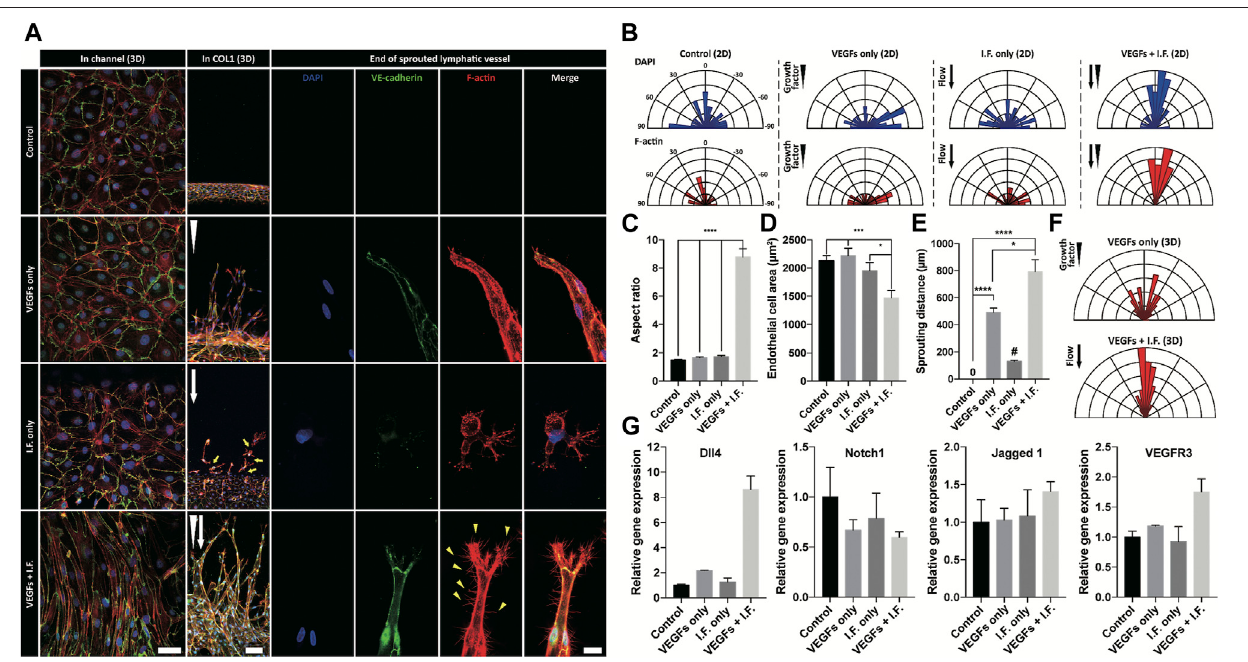
FIGURE 3 | Morphological analysis of lymphatic endothelial cells and sprouted lymphatic vessel under growth factor and interstitial fl ow stimulation. (A) Immuno fl uorescent images of lymphatic endothelial cells in a cell-cultured channel ( fi rst column) , a sprouted lymphatic vessel in COL1 (middle column) , and end of sprouted lymphatic vessel (third column) . White arrowhead and arrow indicate growth factor gradient and interstitial fl ow direction, respectively. Scale bars are 50 μ m ( fi rst column) , 100 μ m (second column) , and 20 μ m (third column). (B) Polar distribution of lymphatic endothelial cell ’ s orientation in the cell-cultured channel (2D)intermsofnuclei (toprow) andcellbody (bottomrow) . (C,D) Morphologicalanalysisoflymphaticendothelialcellinthecell-culturedchannelintermsof (C) aspect ratio and (D) cell area (error bar indicates standard error, and *, ***, and **** indicate p < 0.05, p < 0.001 and p < 0.0001, respectively). (E) Quanti fi cation of lymphatic sprouting distance in COL1 under growth factor and interstitial fl ow stimulation. # indicates single cell migration (error bar indicates standard error, and *and **** indicate p < 0.05, p < 0.001, and p < 0.0001). (F) Polar distribution of sprouted lymphatic vessel ’ s direction in COL1. (G) Gene-level expression related to tip cell and sprouting lymphatic vessel (Dll4, Notch1, Jagged 1, and VEGFR3).